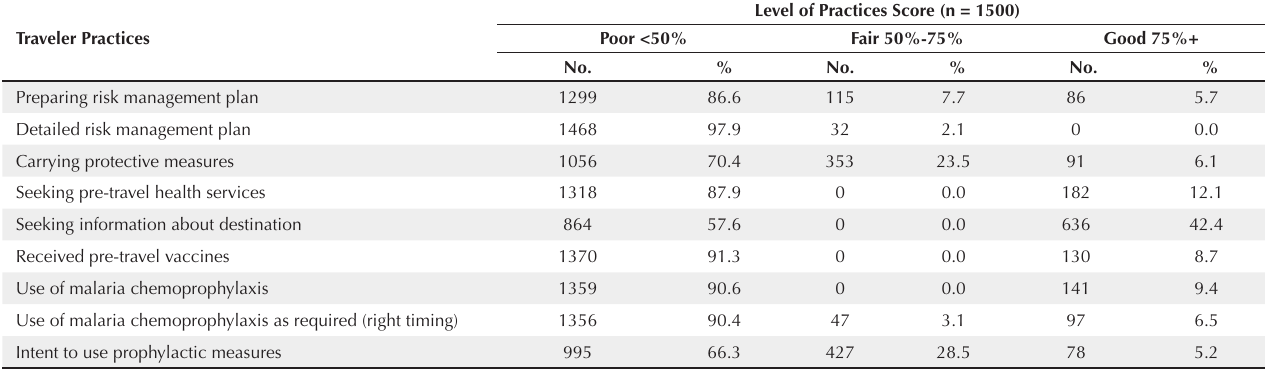
Table 6. Distribution of Travelers at Cairo International Airport According to Level of Travel Health-Related Practices